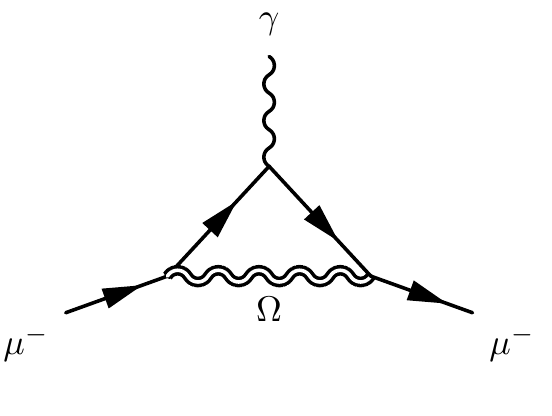
Figure 1 . One-loop Feynman diagrams that would contribute to the muon g − 2